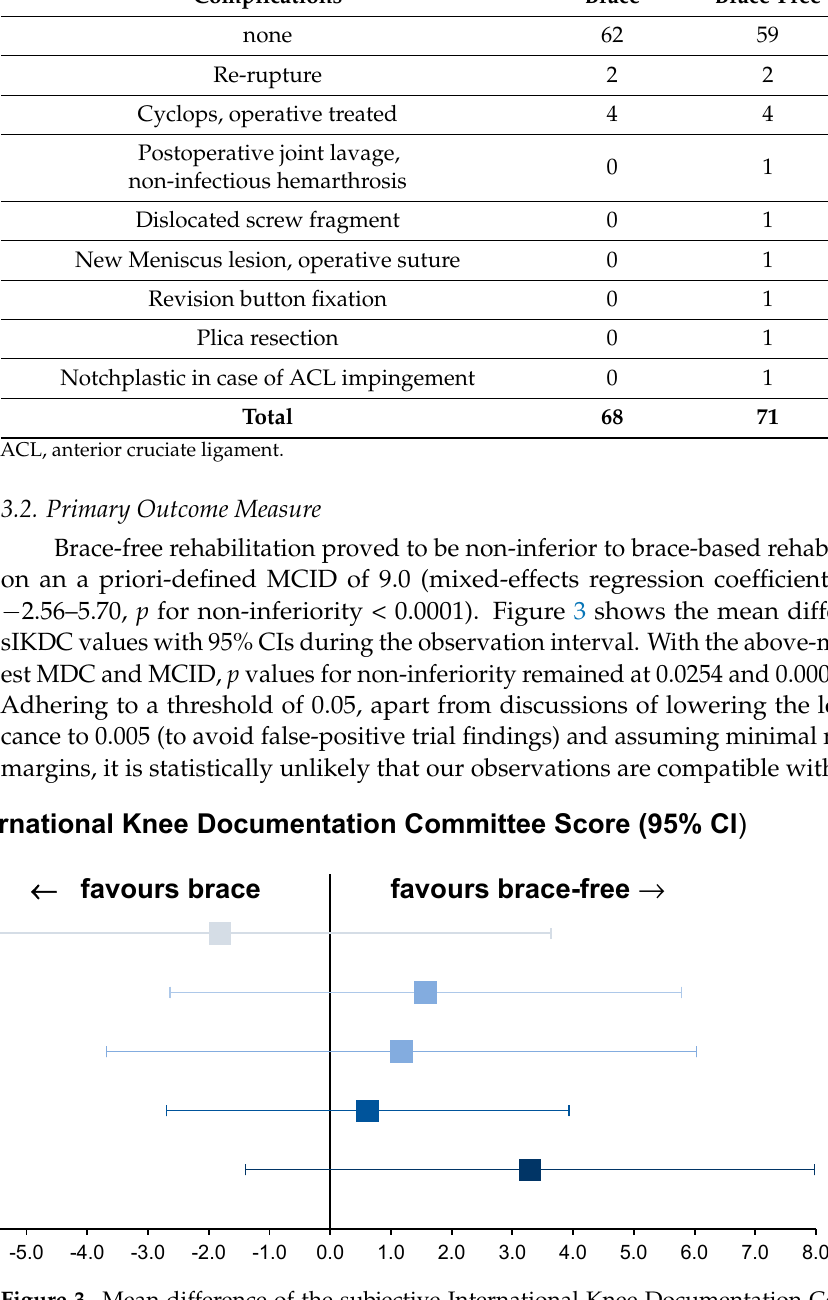
Figure 3. Mean difference of the subjective International Knee Documentation Committee Score values (95% CIs) during the observation interval.